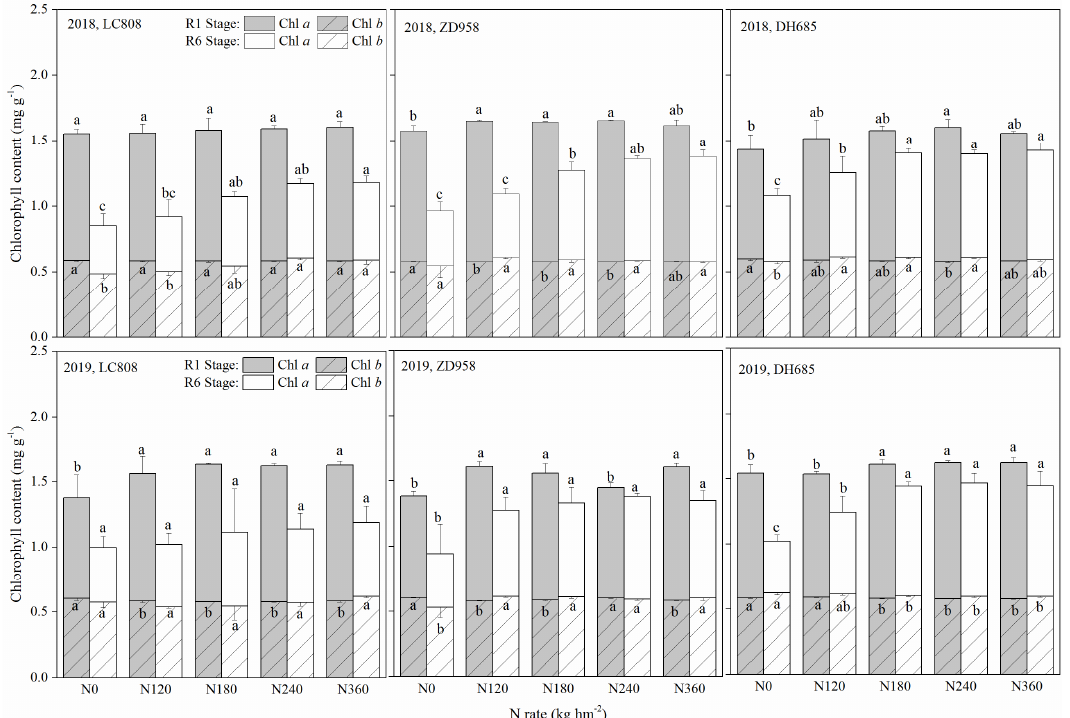
Figure 4. Chlorophyll content of di ff erent stay-green types of maize under the di ff erent N levels. Additional letters represent significant di ff erences ( p < 0.05) in Chl a or Chl b at the same growth stage between the di ff erent N rates. Error bars indicate the SD.